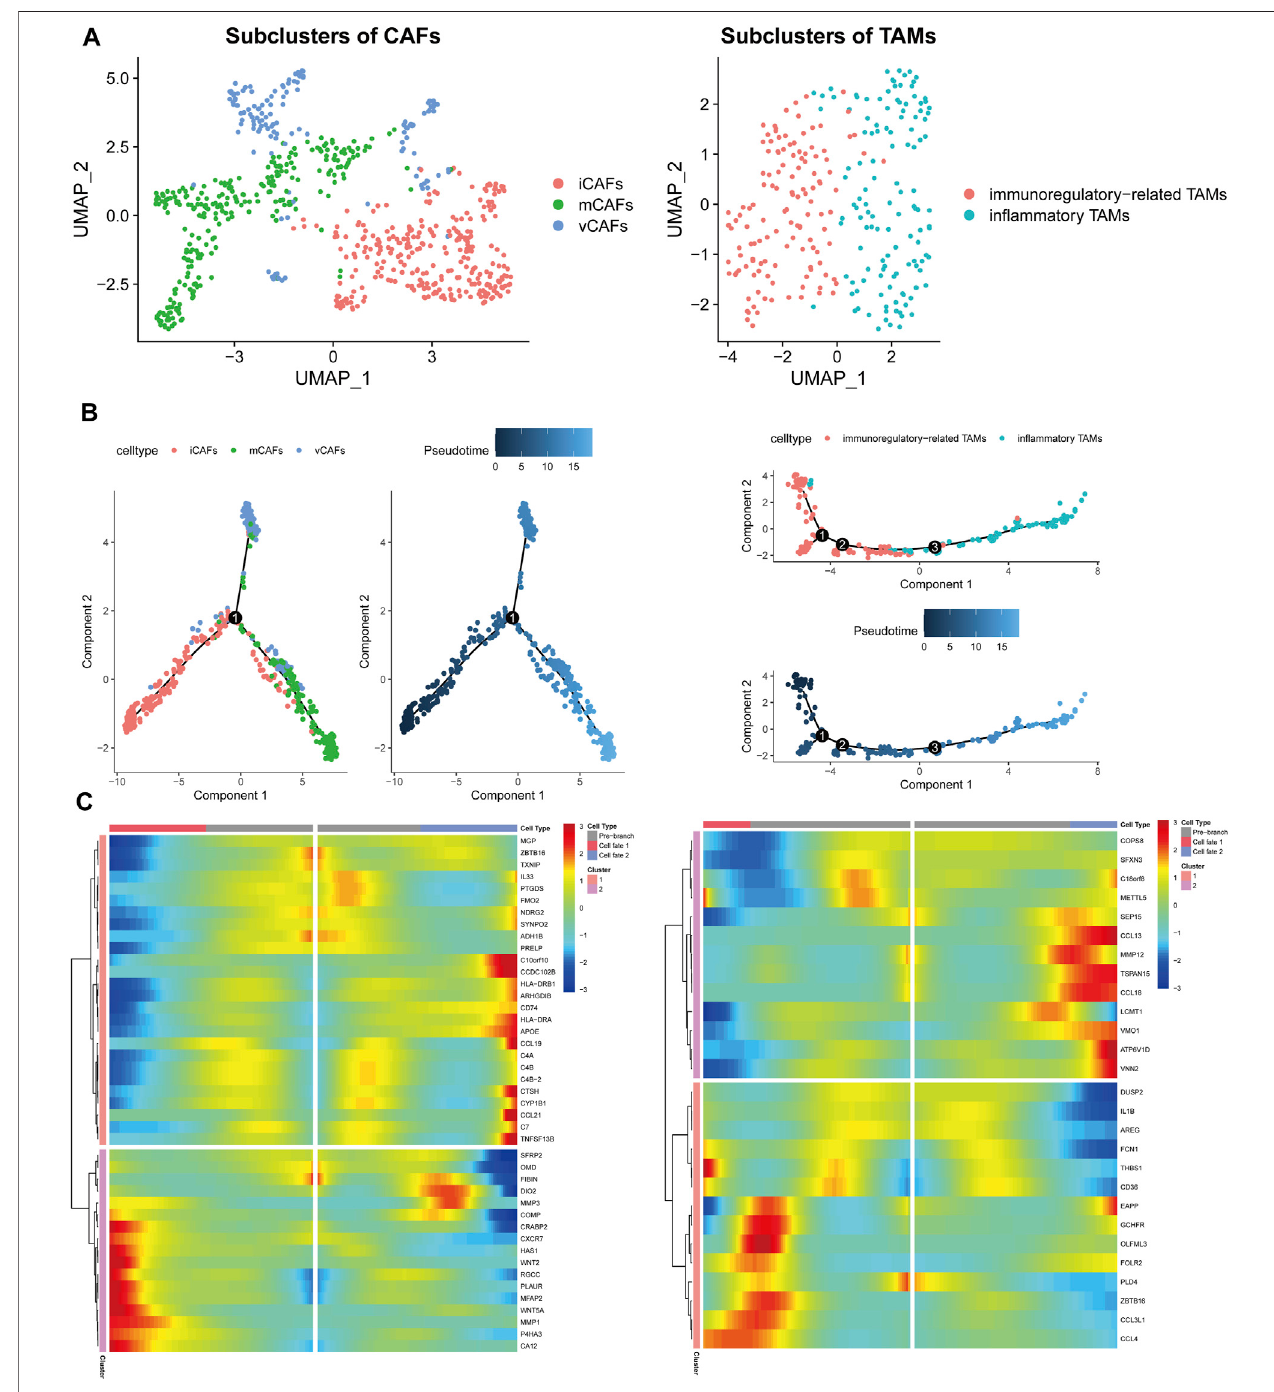
FIGURE 6 | Subpopulations of CAFs (left panel) and TAMs (right panel) identi fi cation and trajectory development investigation. (A) Further clustering CAFs and TAMs according to reported phenotype markers. (B) Investigation differentiation trajectories of subpopulations of CAFs and TAMs through pseudotime analysis. (C) Trajectory branches analysis denoted cell-fate dependent